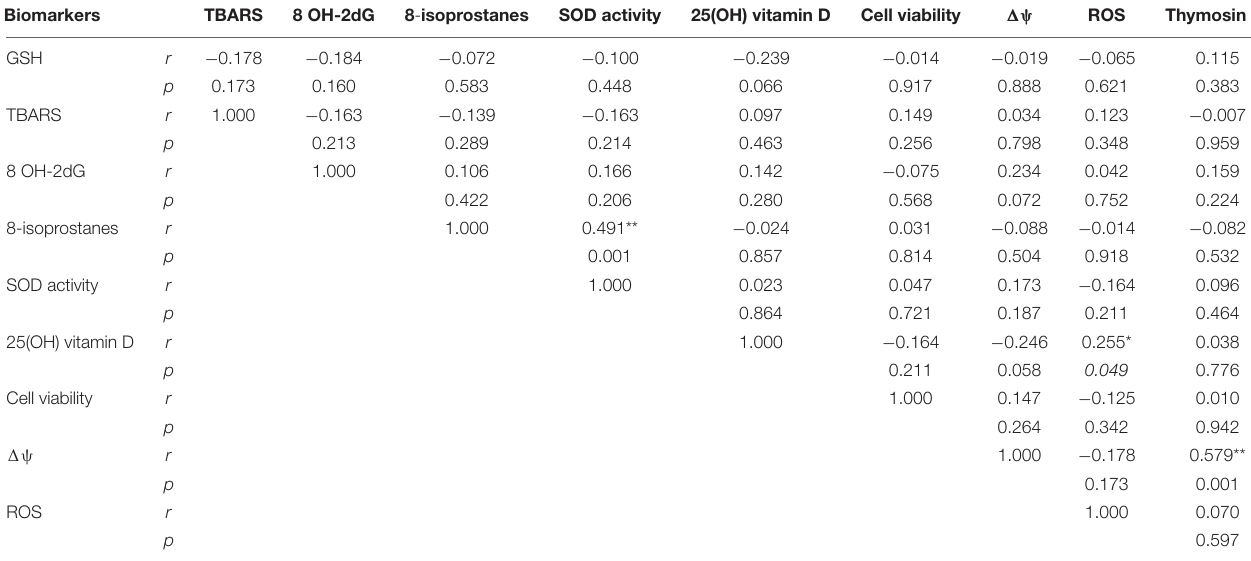
TABLE 2 | Correlations among oxidative stress markers at baseline (January 2020).